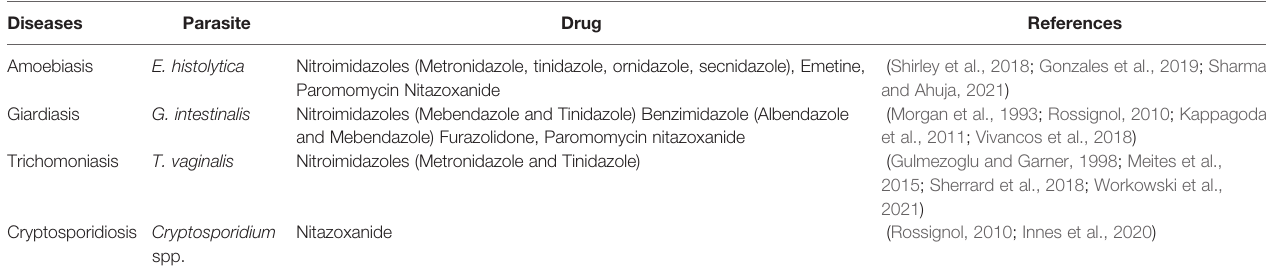
TABLE 1 | Current treatment options for amoebiasis, giardiasis, cryptosporidiosis and